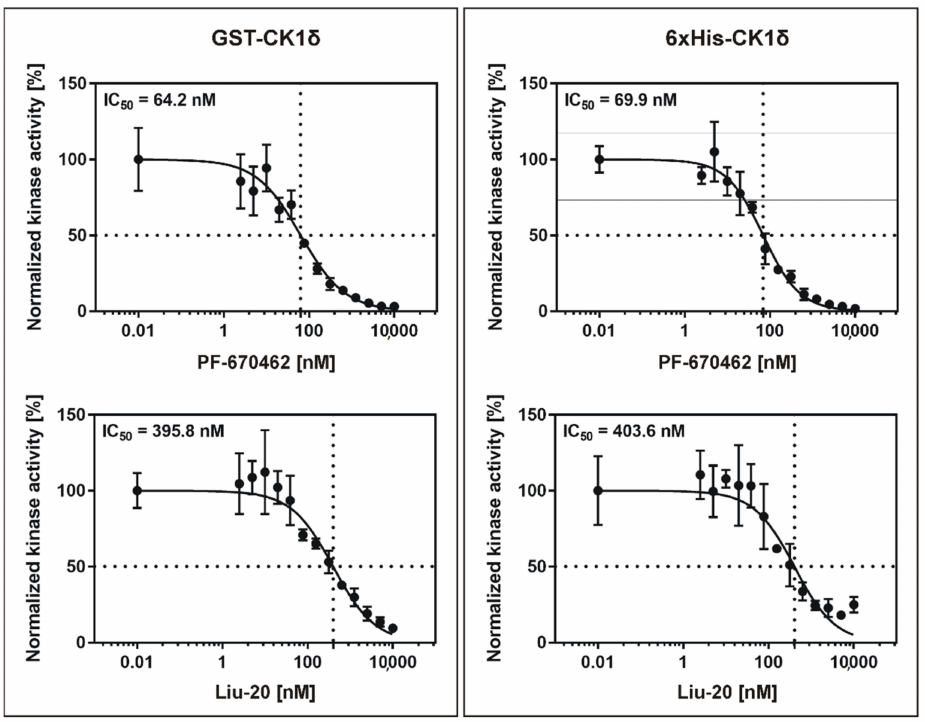
Figure 8. IC 50 values of inhibitors PF-670462 and Liu-20 for GST-CK1 δ and 6 × His-CK1 δ . In vitro kinase reactions were performed in presence of increasing concentrations (1 to 250 nM) of the CK1-specific inhibitors PF-670462 and Liu-20 using GST-CK1 δ (7 nM) or 6 × His-CK1 δ (70 nM) as kinases. Kinase activity was determined by measuring phosphate incorporation into α -casein and data analysis was performed as described in the materials and methods section. IC 50 , concentration for 50%